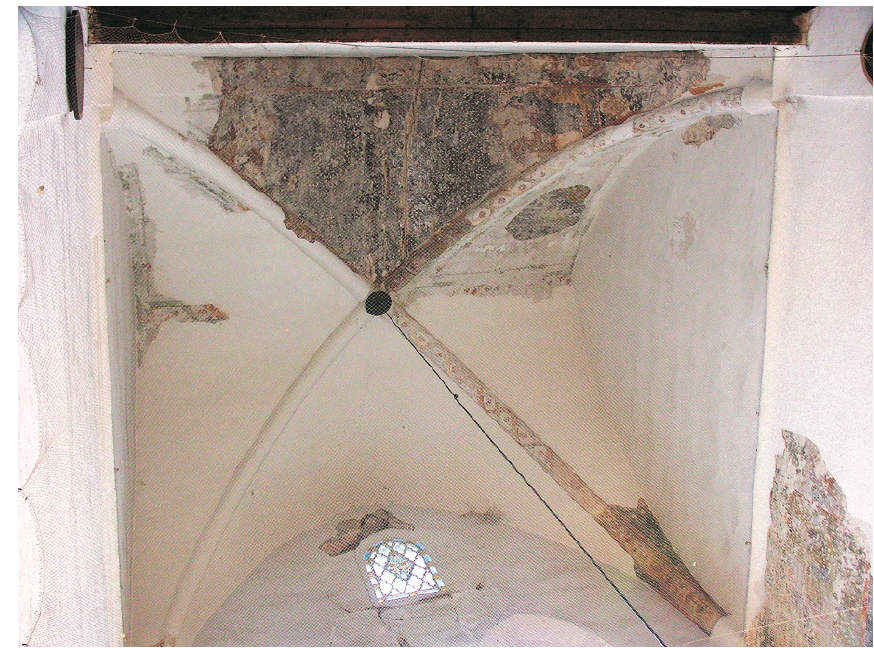
Figure 4. Pera, the church of St. Paul (first quarter of the 14th century), vault of the choir, fot. R. Quirini-Pop ł awski (2007).